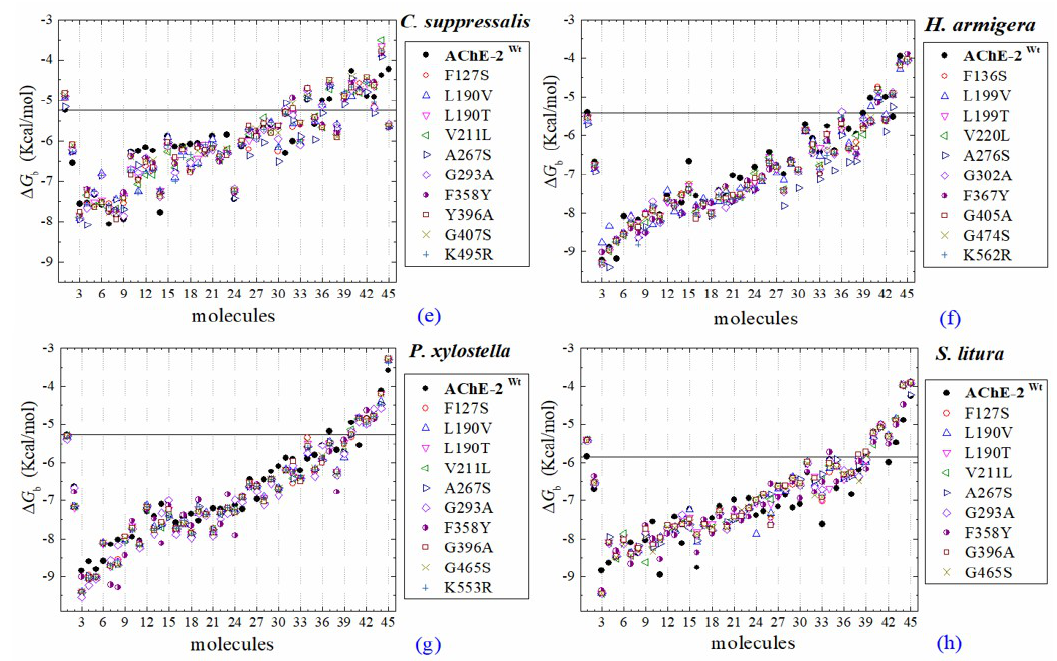
Figure 6. Molecular docking results of AChEs (AChE-2 wild type and AChE-2 modified) in complex with molecules. AChE-2 ( wt , wild type enzyme) of the following organisms: B. mori ( a ), B. mandarina ( b ), C. auricilius ( c ), C. pomonella ( d ), C. suppressalis ( e ), H. armígera ( f ), P. xylostella ( g ), and S. litura ( h ).